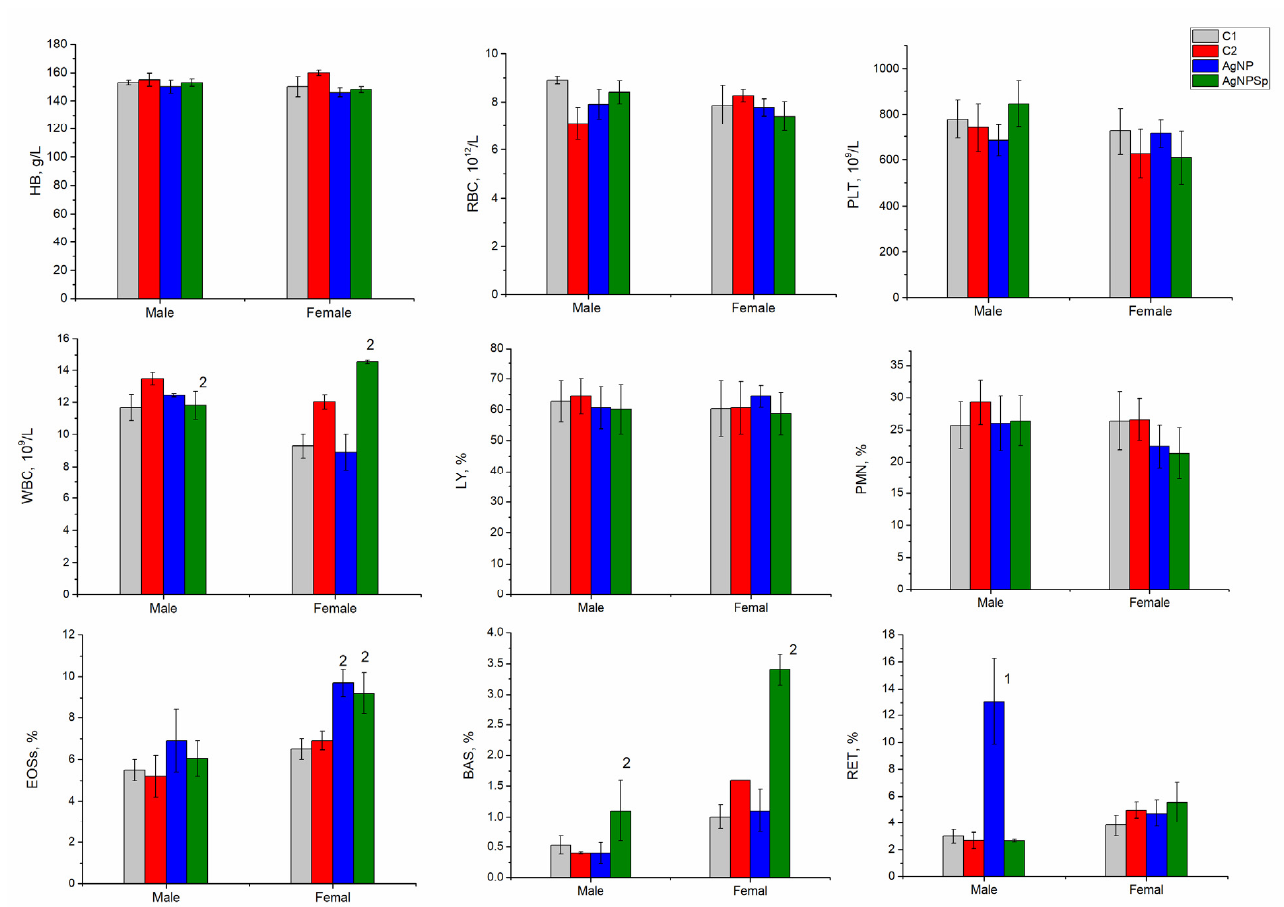
Figure 4. Hematological indices of rats’ blood. C1—negative control; C2—positive control (spirulina); AgNPs—experimental group administrated with AgNPs; AgNPsSp—experimental group administrated with AgNPs-Spirulina. HB—hemoglobin; RBC—red blood cells; WBC—white blood cells; PLT—platelet count; PMN—polymorphomultinuclear neutrophil granulocytes; LY—lymphocytes; EOS—eosinophils; BAS—basophils; RET—reticulocytes. 1: p < 0.005 for differences between the AgNPs and C1 groups; 2: p < 0.005 for differences between the AgNPs-Sp and C2 groups.